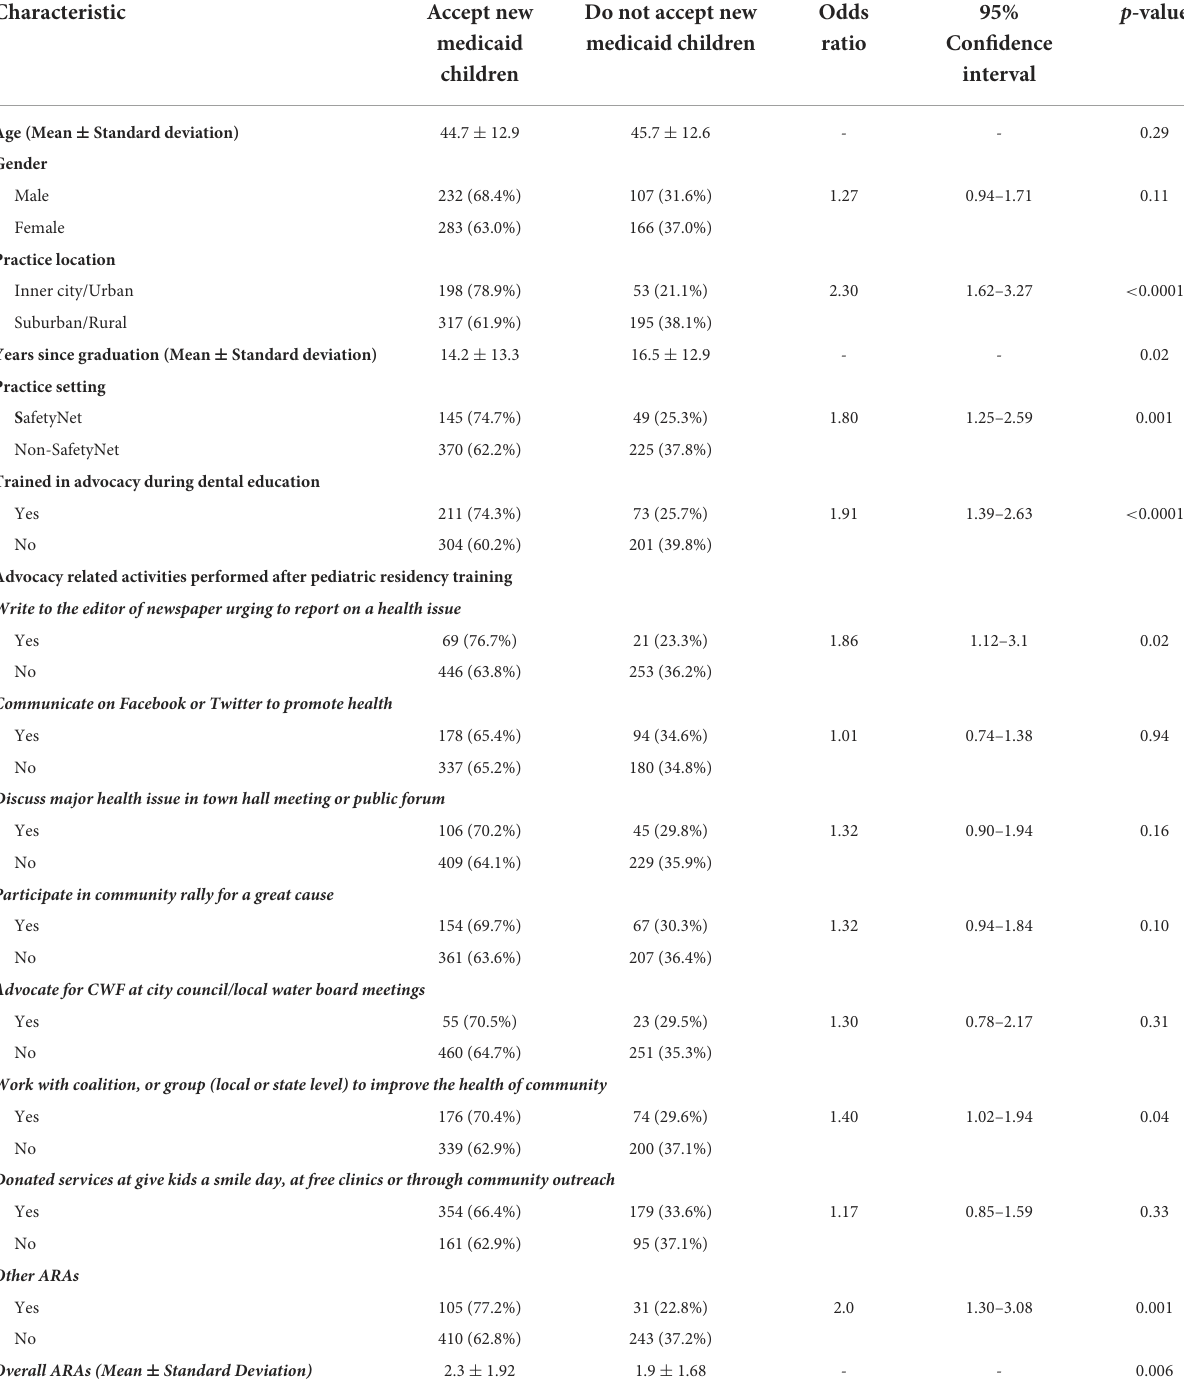
TABLE 2 Comparisons of pediatric dentists who accept and do not accept new Medicaid-enrolled children every month. Characteristic Accept new